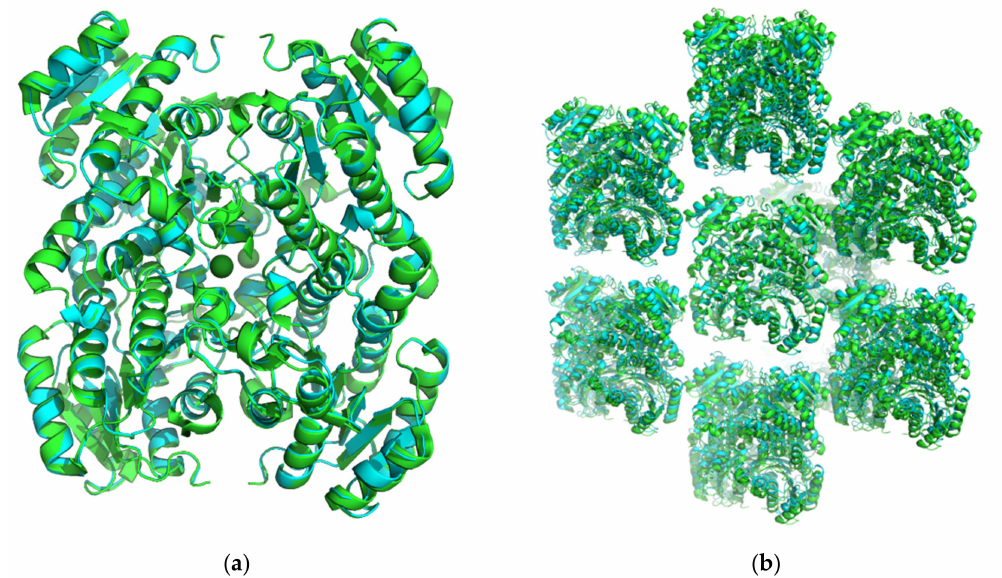
Figure 1. Structural alignment of Lk ADH (cyan; PDB ID: 7P36; R work = 0.9; R free = 0.11) and Lb ADH (green, PDB ID: 6H07) wild type ( a ) tetramers with RMSD backbone = 0.183 Å and RMSD side chain = 0.212 Å and ( b ) with selected symmetry related molecules in the crystal structure. Figures were generated with PyMOL (v.2.3; Schroedinger). The homotetramers are complexing two Mg 2+ ions (dark